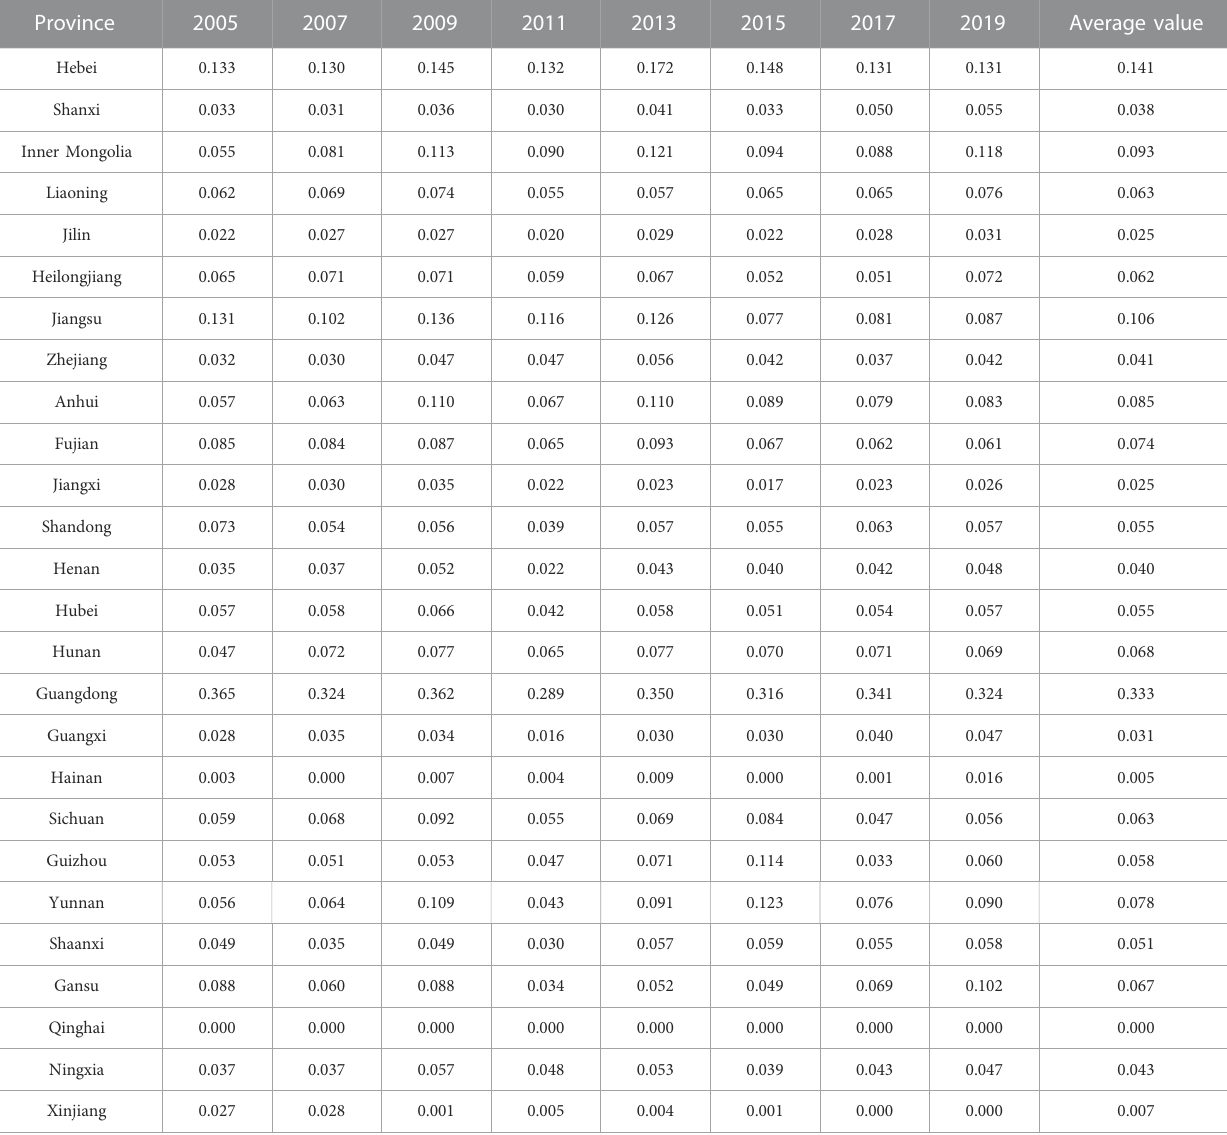
TABLE 2 Intra-provincial differences in economic resilience of Chinese cities.